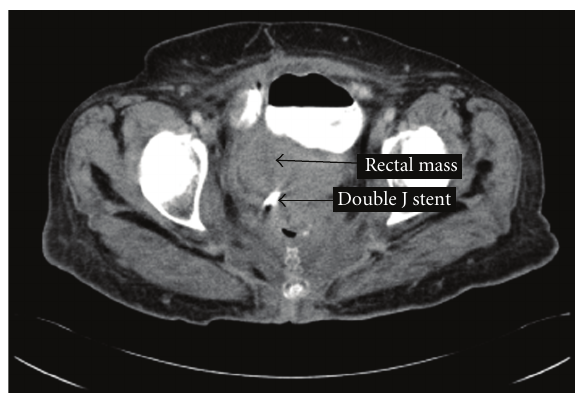
Figure 1: CT scan of pelvis showing rectal mass and double J stent.